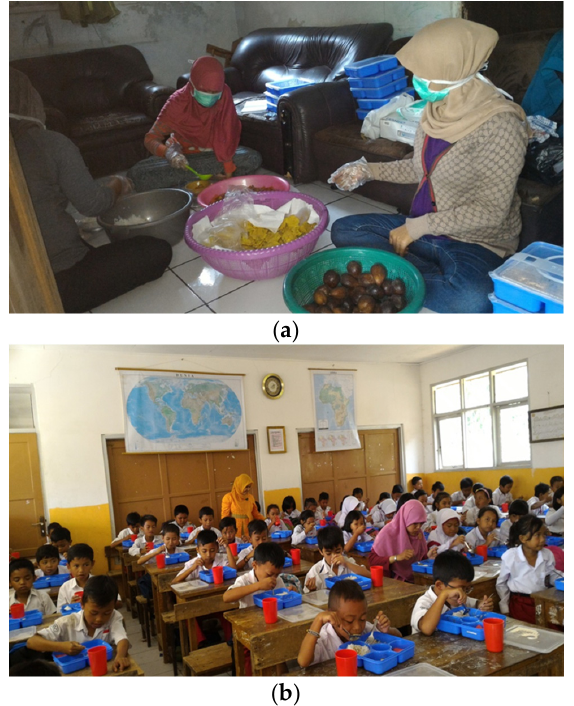
Figure 1. Scenes from our school lunch intervention. ( a ) Village women preparing dishes for lunch. ( b ) Schoolchildren eating lunch. ( b ) Schoolchildren eating